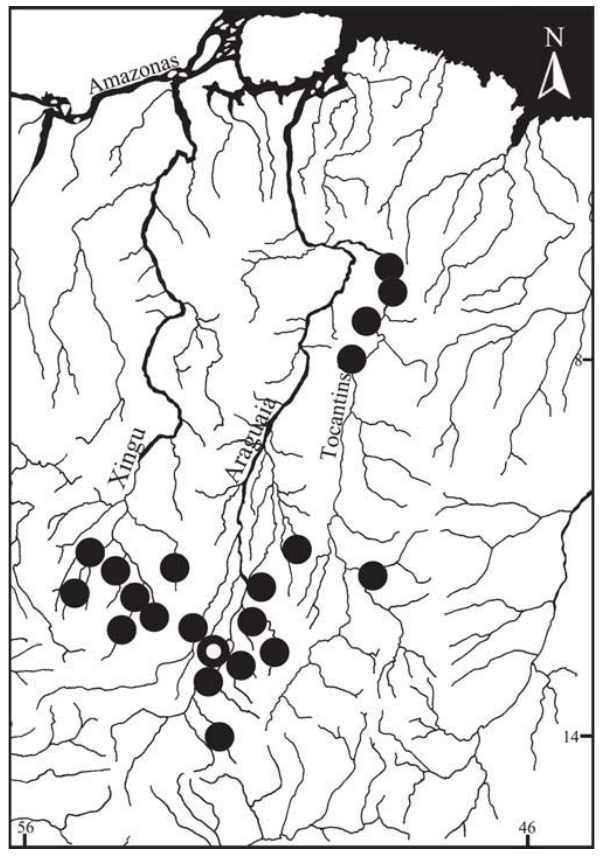
Fig. 3. Map of rio Tocantins, rio Xingu, and adjoining river basins, showing the geographic distribution of Hypostomus faveolus (type locality represented by open